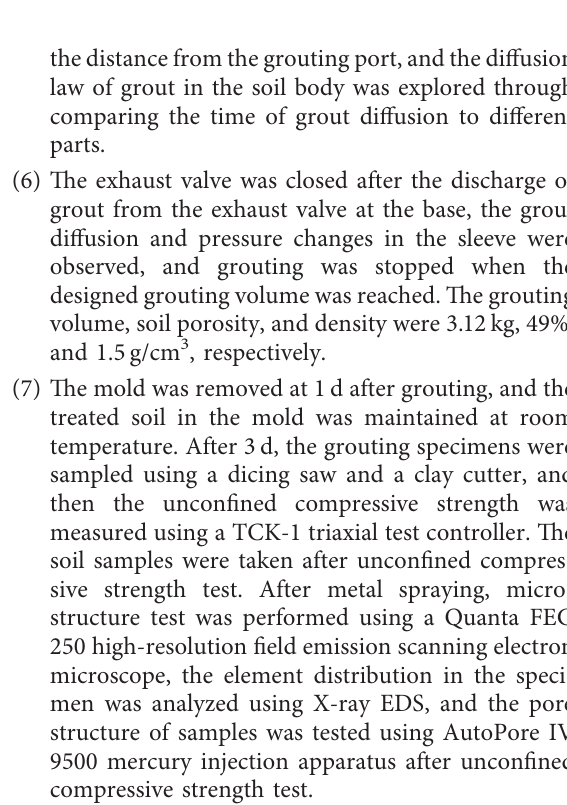
Figure 2: Picture of the experimental